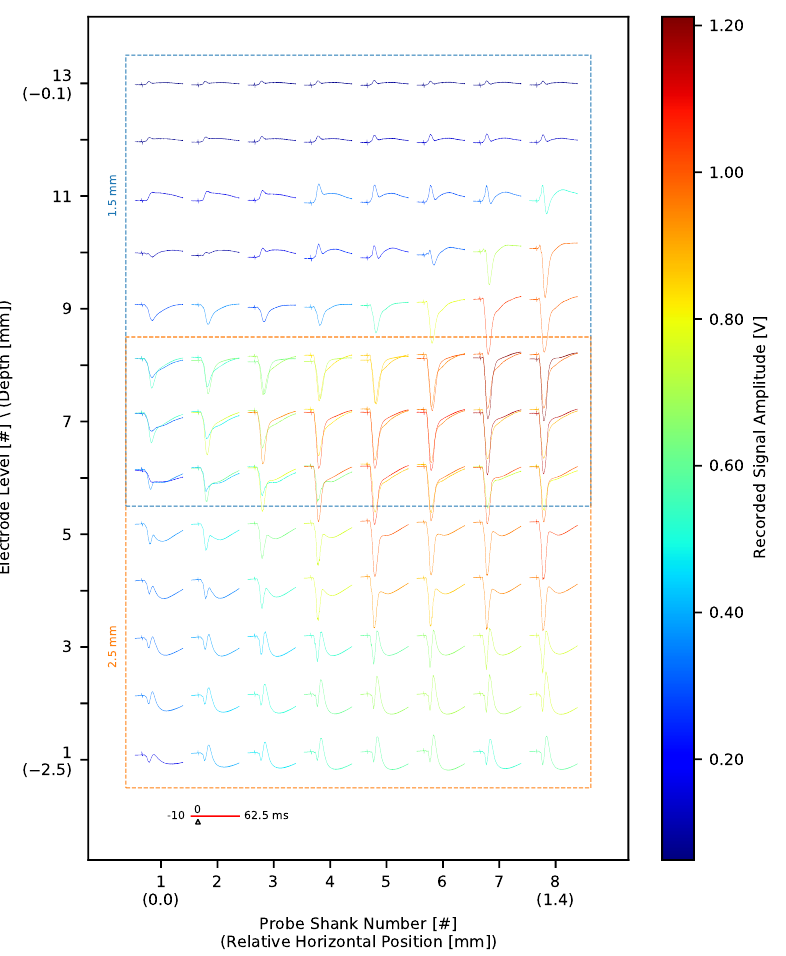
Figure 27. Average ( n = 100) evoked potential responses to whisker stimulation calculated for all MEA sites placed in a rat barrel cortex. To monitor activity of all cortical layers, the recording was repeated with MEA placed at the depth of 1.5mm and 2.5mm from the cortical surface. We can see that different MEA sites were effectively recording very similar signals from the same locations (marked with overlapping rectangles). Each average response is 62.5ms long with 10ms pre-trigger LFP and its amplitude is colour-coded (note that gain correction was not